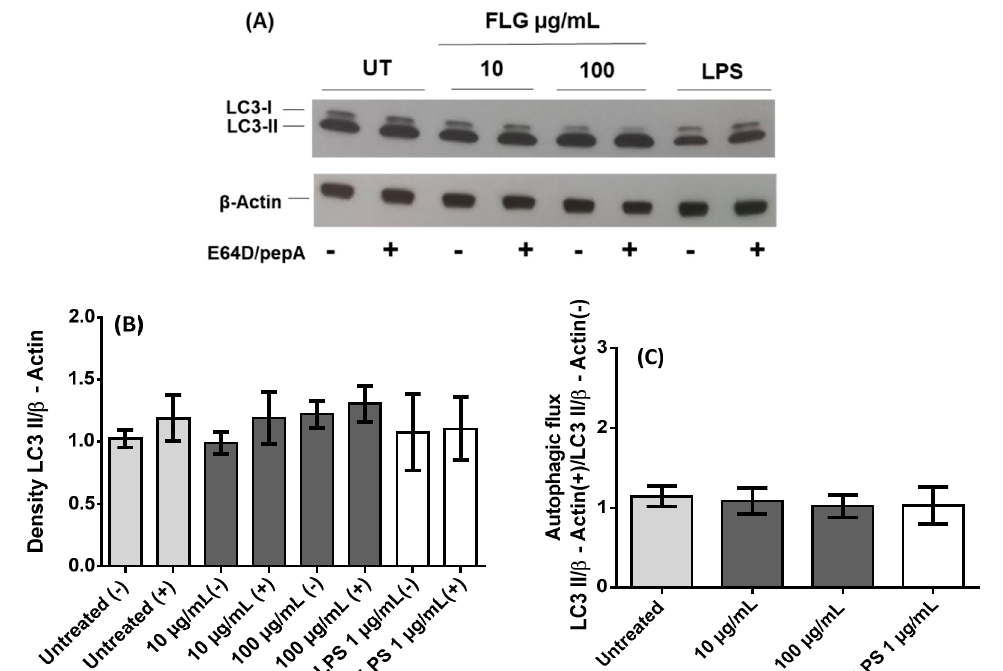
Figure 2. Autophagy analysis in BMDMs after 24 h interaction with FLG. ( A ) Representative Western blot of di ff erent samples as indicated for LC3 proteins along with internal loading control β -actin both in the presence ( + ) and the absence ( − ) of protease inhibitors E64D and pepstatin A (pepA). Untreated control (UT) ( B ) Relative quantification of density ratio of LC3-II to β -actin corresponding to conditions mentioned earlier. ( C ) Densitometric evaluation, using ImageJ, of the autophagic flux considering the ratio between the presence ( + ) and the absence ( − ) of E64D / pepA of the autophagic activity (LC3-II / β -actin). A One-way ANOVA followed by Bonferroni’s post-test was performed to determine the statistical di ff erences for control untreated cells versus FLG-treated samples and LPS-treated cells ( p >